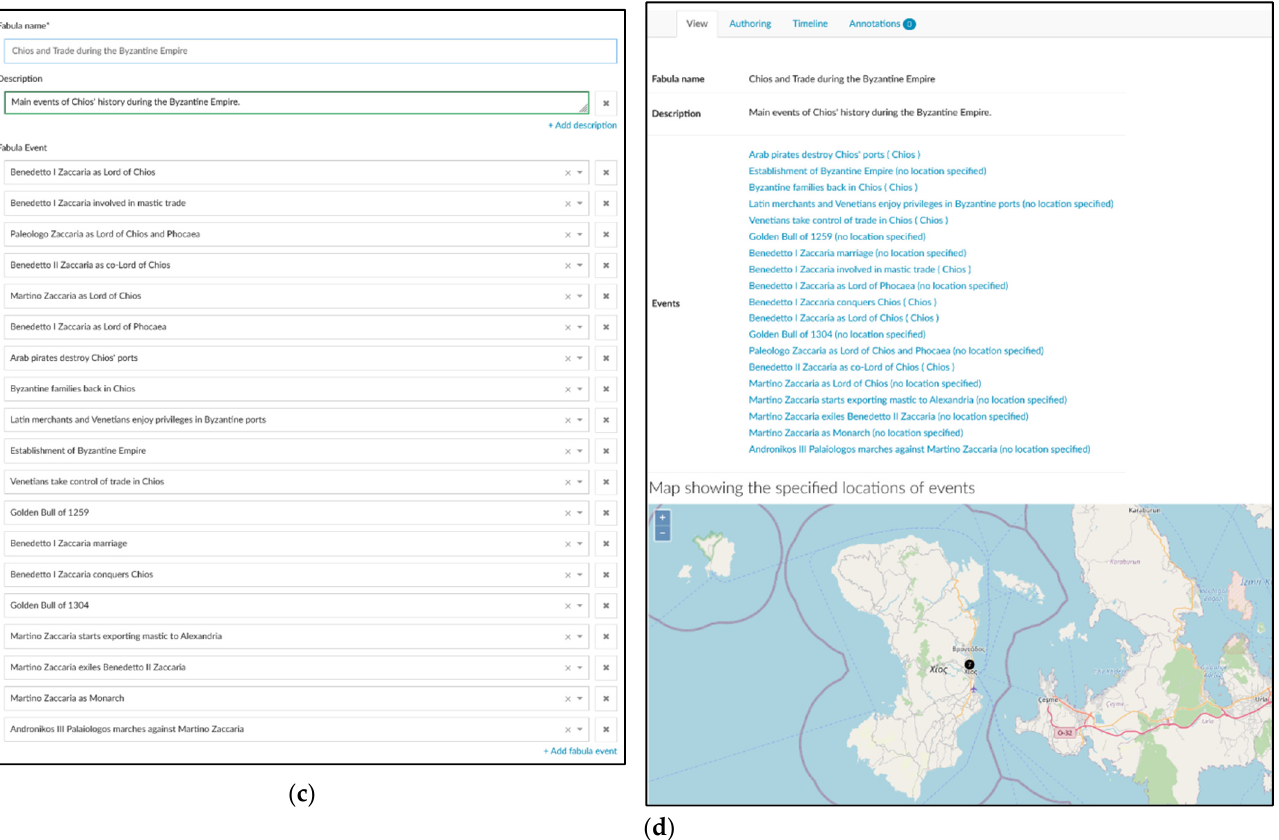
Figure 7. Fabula authoring—“Chios and Trade during the Byzantine Empire”. ( a ) Event page, ( b ) Event authoring form, ( c ) Fabula authoring form, ( d ) Fabula page.